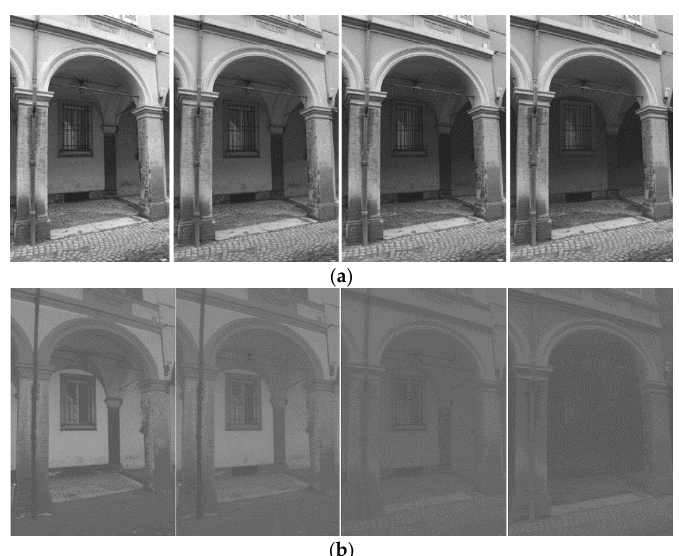
Figure 5. Results of color-to-gray conversion methods: Produced gray scale images ( a ) and image difference ( b ) between (from left to right) Adobe Photoshop and Decolourize , Adobe Photoshop and Realtime , Adobe Photoshop and Matlab RGB2GRAY , and Adobe Photoshop and BID .